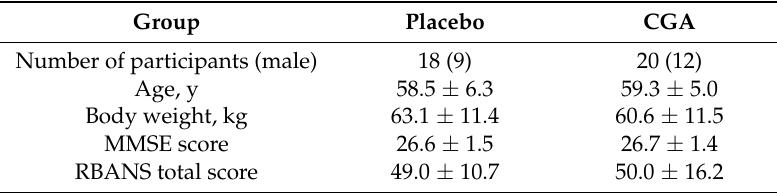
Table 2. Baseline characteristics of participants.